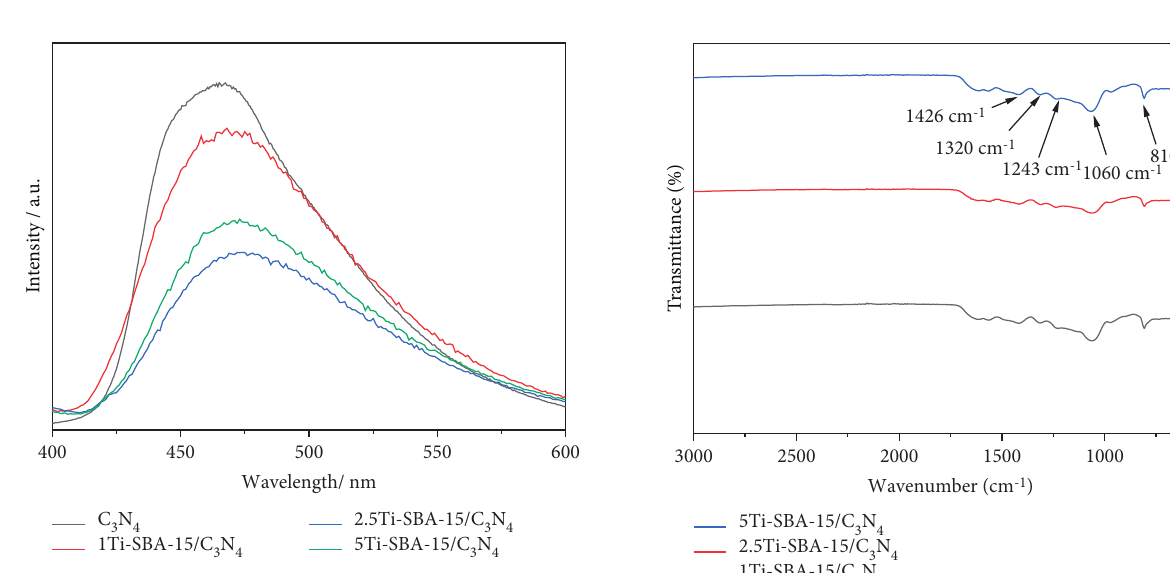
3 N 4 and xTi-SBA-15/C 3 N 4 .